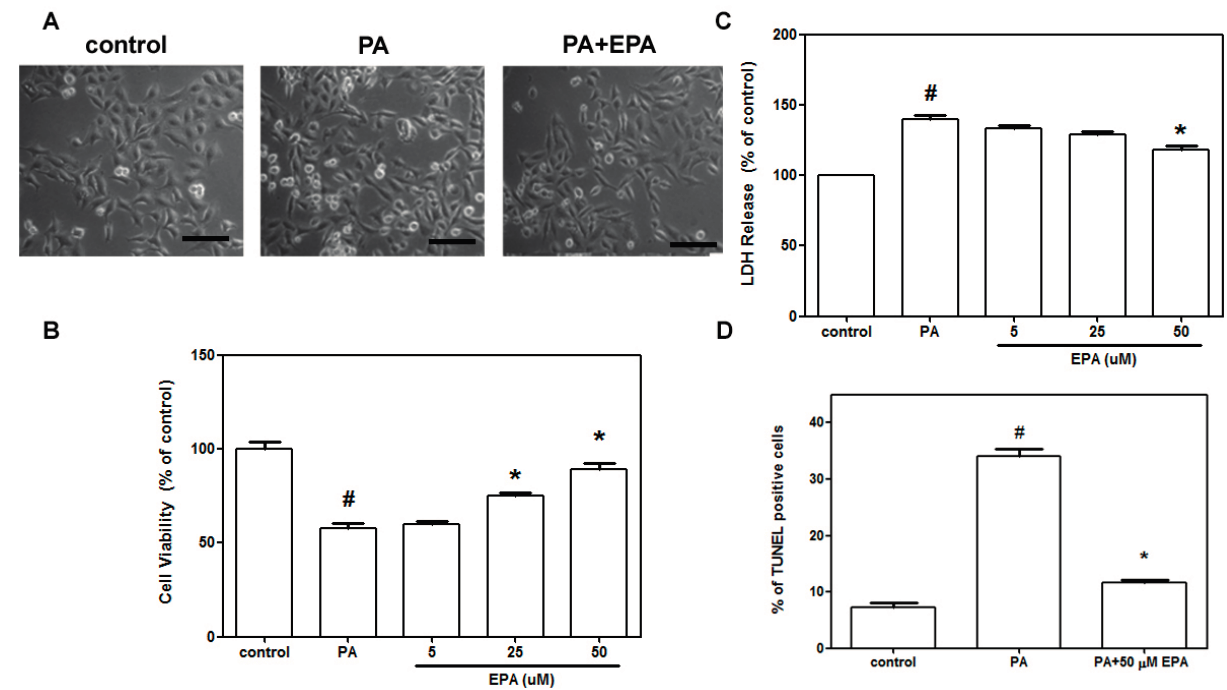
Figure 1. Effects of EPA on PA-induced endothelial cell death. After pretreatment with or without EPA for 2 h, the HUVECs were treated with 0.5 mM PA for 18 h in the presence of 50 μ M EPA. Photomicrographs from phase-contrast microscopy ( A ); Cell viability was measured via the MTT assay ( B ); Cell death was determined by LDH release ( C ); Apoptotic cells were evaluated using the terminal deoxynucleotidyl transferase-mediated dUTP nick end-labeling (TUNEL) staining assay ( D ). The data are expressed as the means ± the S.E.s of five independent experiments. # p < 0.05 vs. untreated control; * p < 0.05 vs. PA treatment. Scale bar = 100